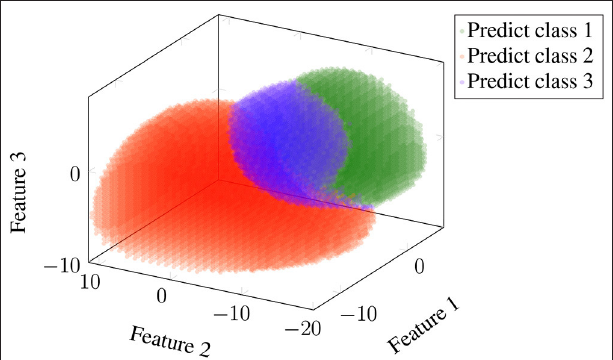
FIGURE 2 | Visualisation of classification results of Classifier 1. This figure shows results for Subject 3 of Dataset 1. All trials but the first were used in training, and features were the combination of canonical correlation analysis (CCA) and power spectral density analysis (PSDA). The information bottleneck parameters were set to α 1 and β 100. Probabilities were estimated using = = the skew-normal distribution. Classification results on training data divide the feature space into three regions based on which the testing data is classified. Classes 1, 2, and 3 correspond to frequencies of 8, 14, and 28 Hz,